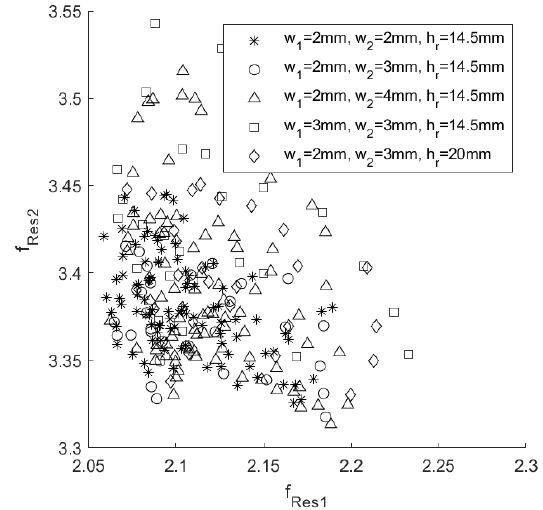
Figure 10. Representation of the couples of resonance frequencies of different tag families characterized by different thicknesses and heights. w 1 is the thickness of the first empty ring, w 2 is the thickness of the second one, and h r is the height of both rings.